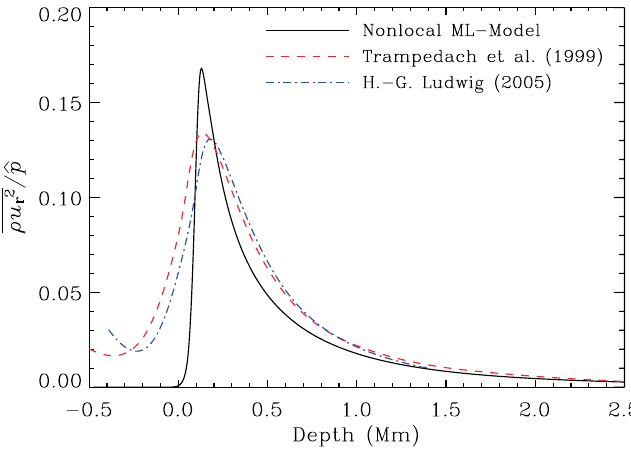
Figure 3: Turbulent pressure 𝑝 t := 𝜌𝑢 2 𝑟 over total pressure ^ 𝑝 = 𝑝 + 𝑝 t as a function of the depth variable 𝑅 ⊙ − 𝑟 for various solar simulations and models ( 𝑅 ⊙ is the photospheric solar radius). Results are shown for the nonlocal mixing-length model of Section 3.3.1 by Gough (1977a,b, solid curve) and from hydrodynamical simulations by Regner Trampedach (1999, personal communication, dashed curve) and H.-G. Ludwig (2005, personal communication, dot-dashed